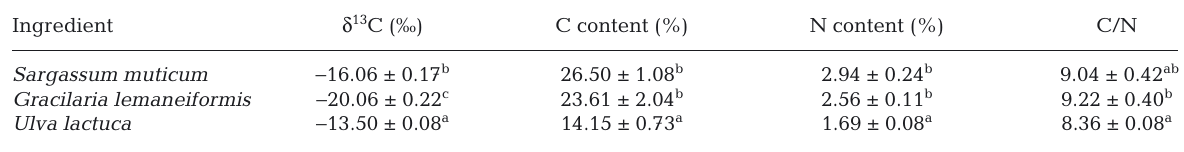
Table 1. Carbon stable isotope ratios ( δ 13 C), C and N contents, and C/N ratios of macroalgae used as dietary ingredients in a study of the feeding habit of sea cucumber Apostichopus japonicus . Data are presented as mean ± SD (n = 3). Different letters within the same column indicate significant differences (ANOVA, p < 0.05)